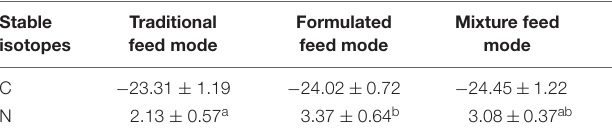
TABLE 3 | Analysis of variance of 13 C and 15 N isotope contents in muscle of Chinese mitten crab in different feeding modes (